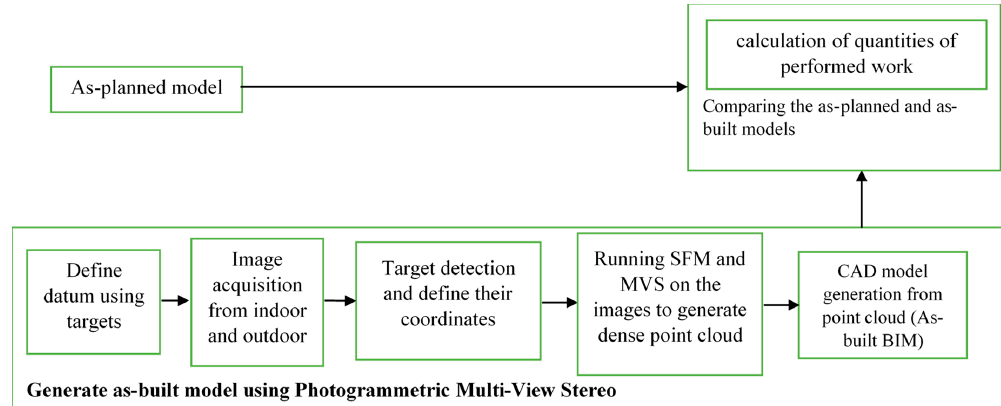
Figure 1. The flowchart diagram of different stages of construction progress monitoring using the proposed approach.